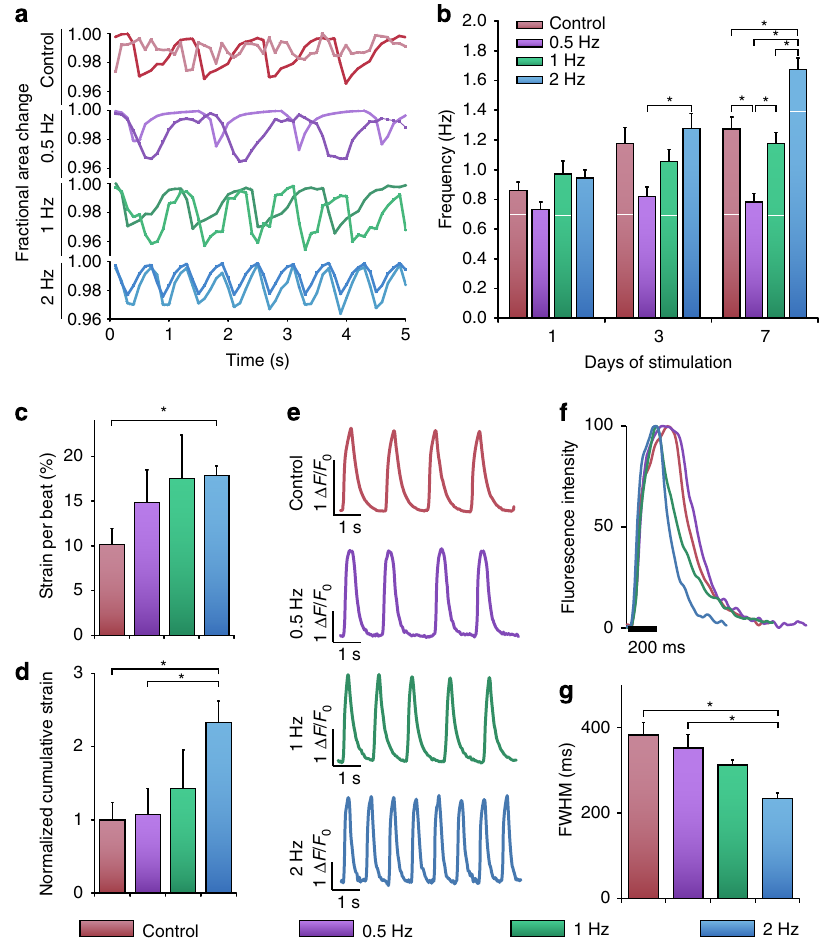
Figure 2 | Electrical stimulation regulates automaticity in human stem cell-derived cardiomyocytes. ( a ) Fractional area change as a function of time after 7 days of stimulation. Dark and light traces represent two independently beating areas within the same field of view. ( b ) Frequency of autonomously beating cardiomyocytes as a function of duration of stimulation (average ± s.e.m., n ¼ 30, P o 0.05). ( c , d ) Strain rate per beat and the cumulative contraction strain (average ± s.e.m., n ¼ 3, P o 0.05). ( e ) Calcium fluorescence traces for an entire beating area over time. ( f ) Normalized fluorescence intensity over one beat. ( g ) Full width half maximum (FWHM) calcium transients for stimulated groups (average ± s.e.m., n ¼ 23, P o 0.05). *Statistically significant differences between groups, testing was done using one-way ANOVA with post hoc Tukey